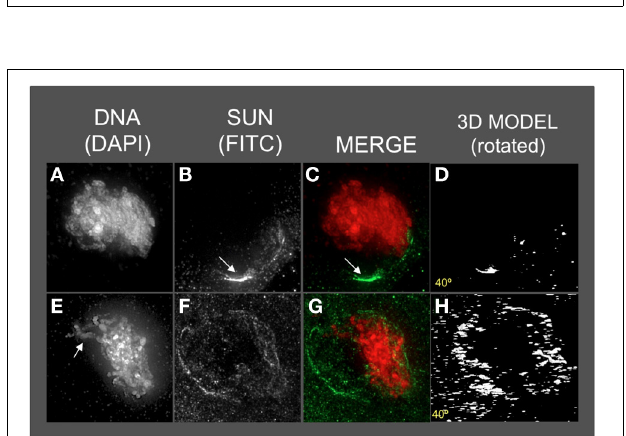
2001; Chikashige et al., 2006), in S. cerevisieae meiosis (Conrad et al., 2008; Lee et al., 2012), or the telomere-like pairing